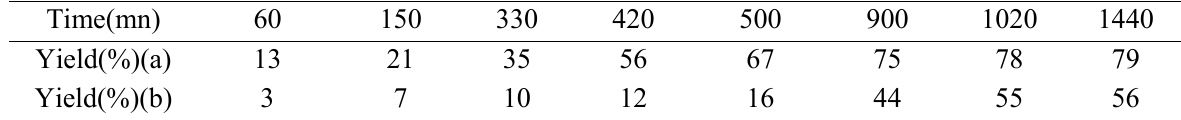
Table 4 Epichlorhydrin conversions with time : for 10g of Epichlorhydrin, the amounts of H-Magh- nite0.25M were: a)1g b)0.5g